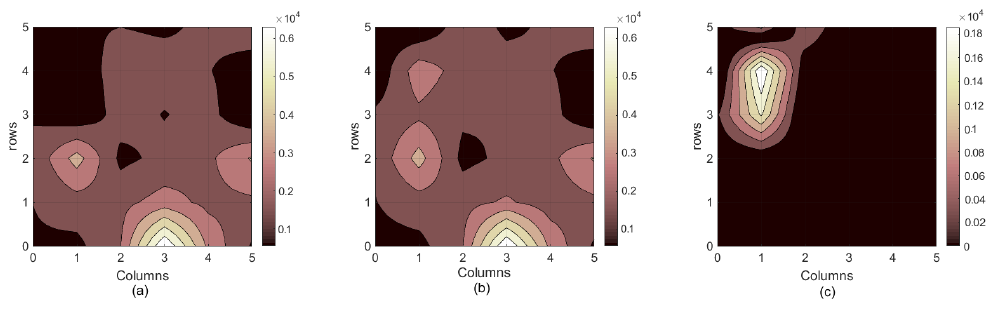
Figure 18. 2D mapping of soil compaction dynamics: ( a ) C B , ( b ) C A and ( c ) C A − C B